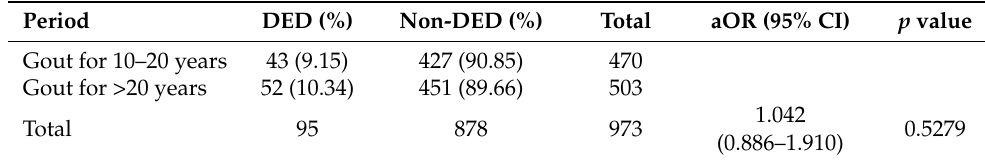
Table 4. The distribution of dry eye in persistent-gout patients with different disease periods. Period DED